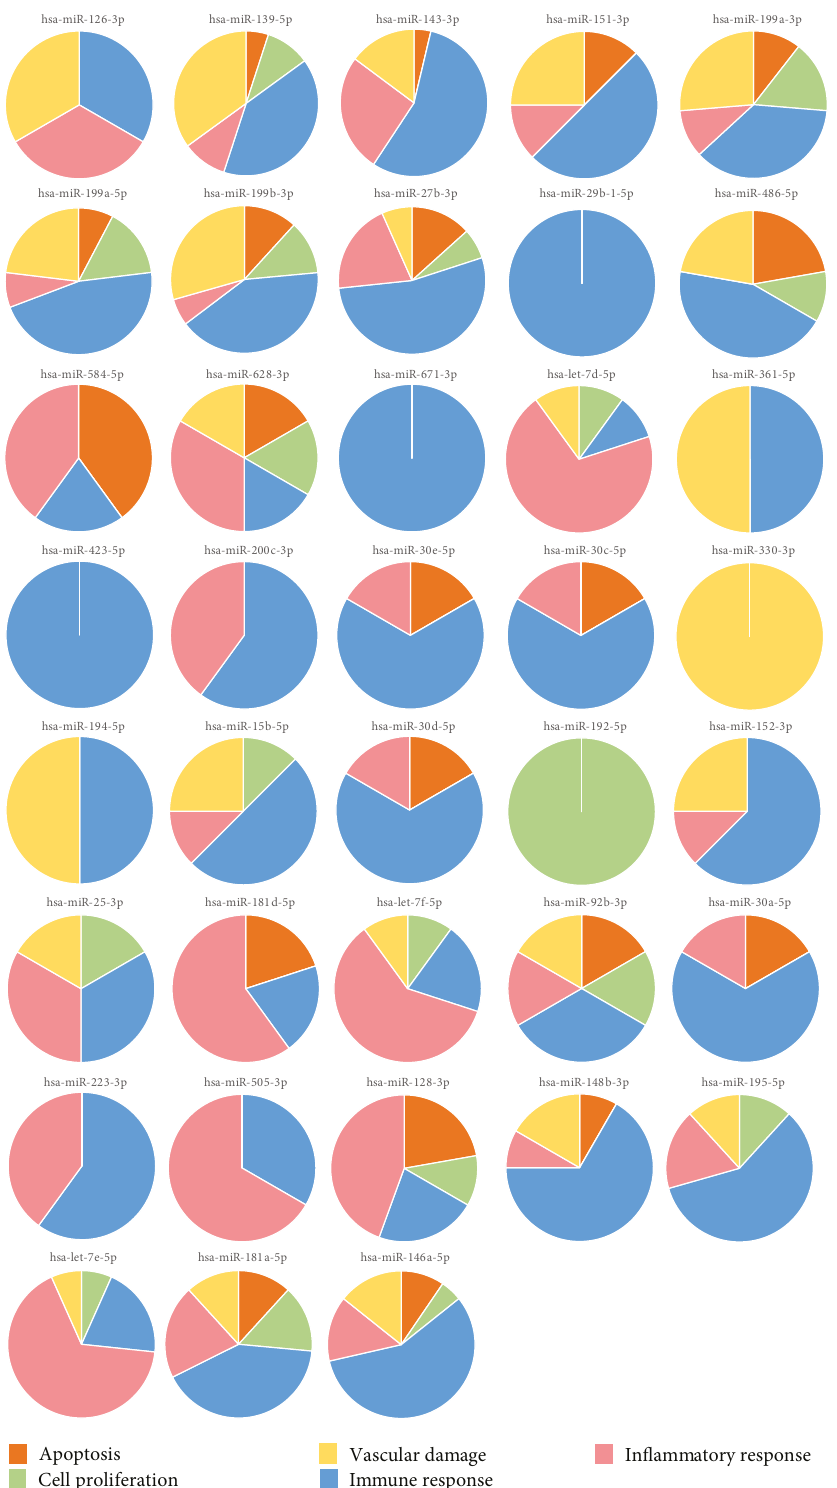
Figure 4: Functional classi fi cation of BD DEGs targeted by selected miRNAs. Pie charts showing the di ff erent GO biological processes in which BD DEGs targeted by selected deregulated miRNAs in BD can be classi fi